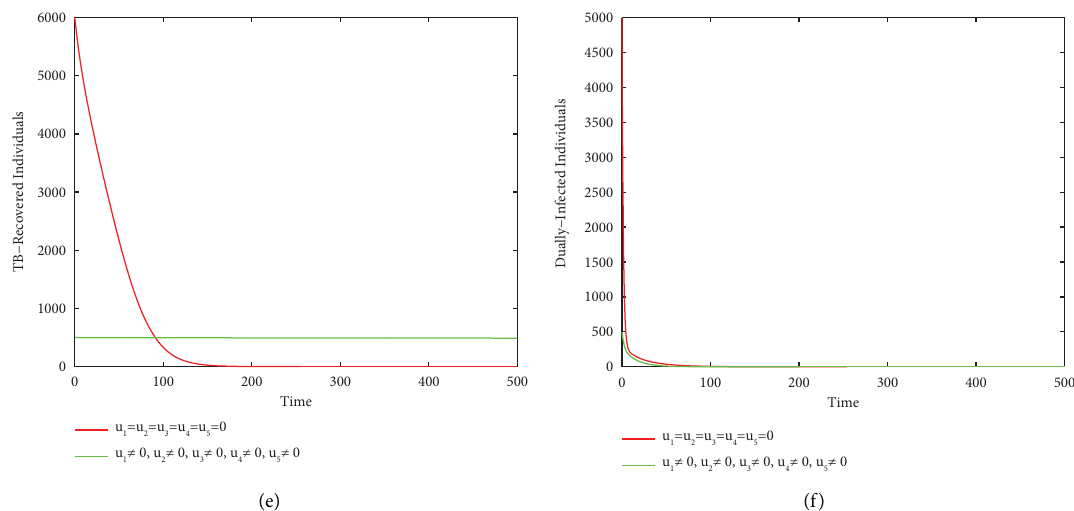
Figure 2: Simulation results for the implementation of both preventative and curative measures along with skills training in combating the spread of HIV-TB co-infection.